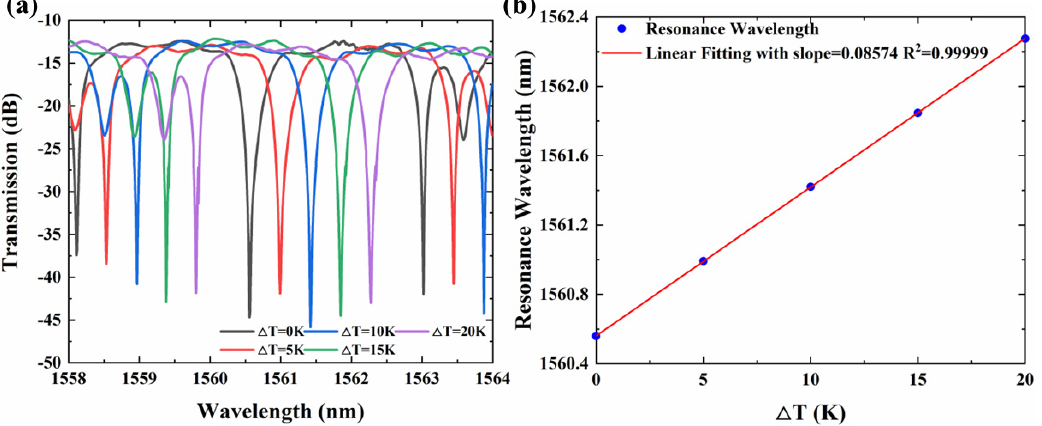
Figure 3. ( a ) Spectra of the dual-MRR sensor at different temperatures (ranging from 0 K to 20 K). ( b ) Overlapping resonant peak wavelength at different temperatures.